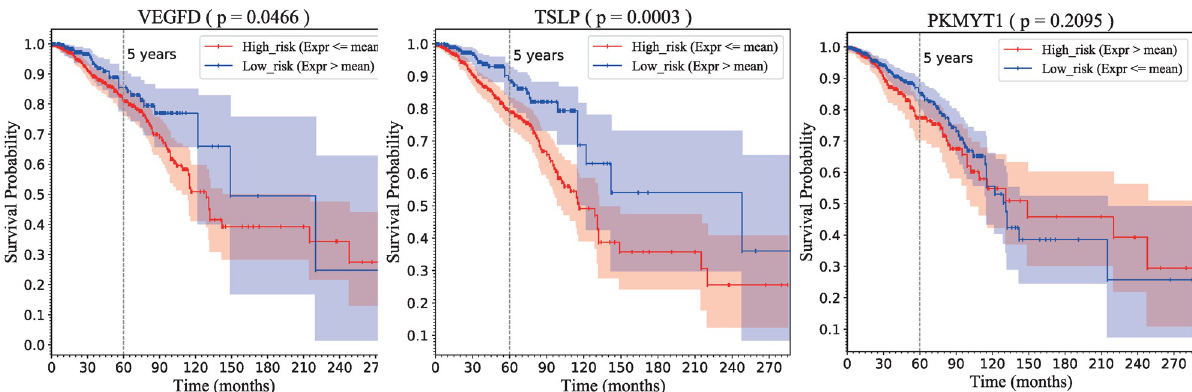
Fig 8. Kaplan–Meier survival graphs for expression of VEGFD, TSLP, and PKMYT1. Red and blue curves denote high-risk and low-risk groups,